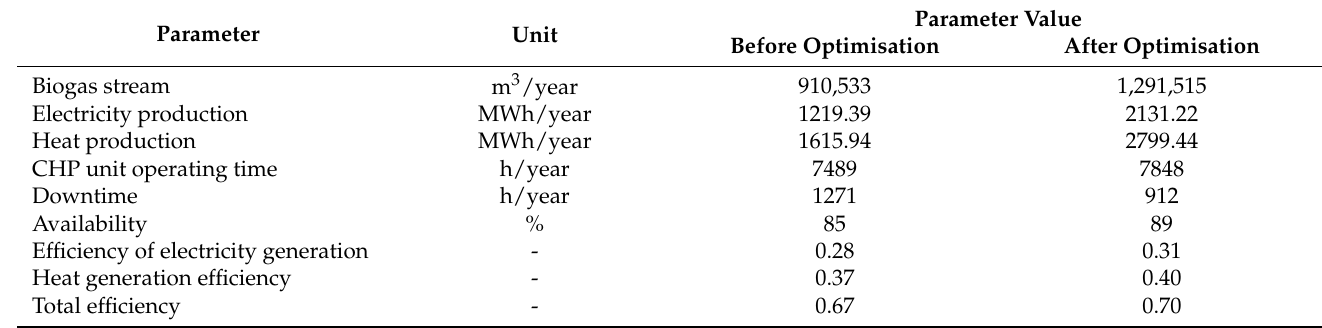
Table 8. Comparison of optimisation